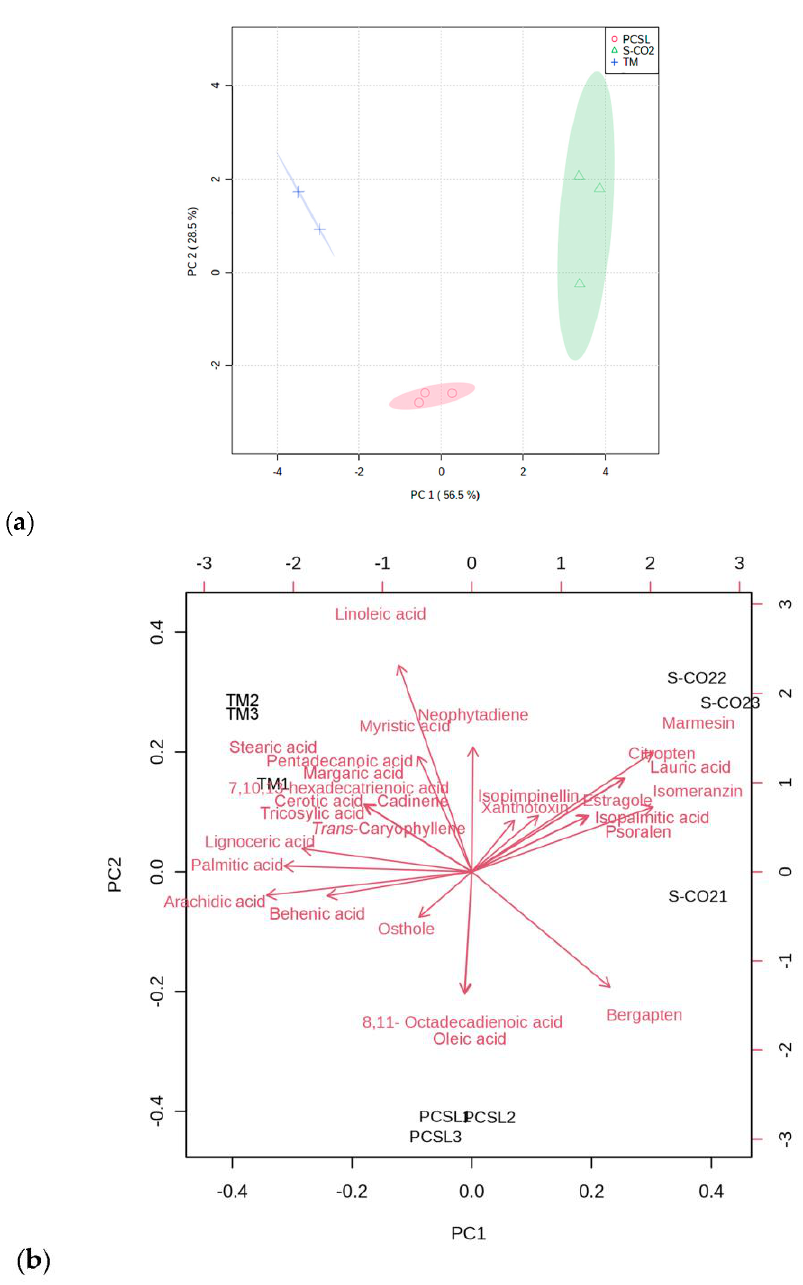
Figure 1. Scores plot ( a ) and loadings bi-plot (PC-1 vs. PC-2) ( b ) of P. ferulacea extracts’ phytochemical profile. Abbreviations are as follows: TM, traditional maceration; PCSL, pressurized cyclic solid– liquid extraction, S-CO 2 : supercritical CO 2 extraction.